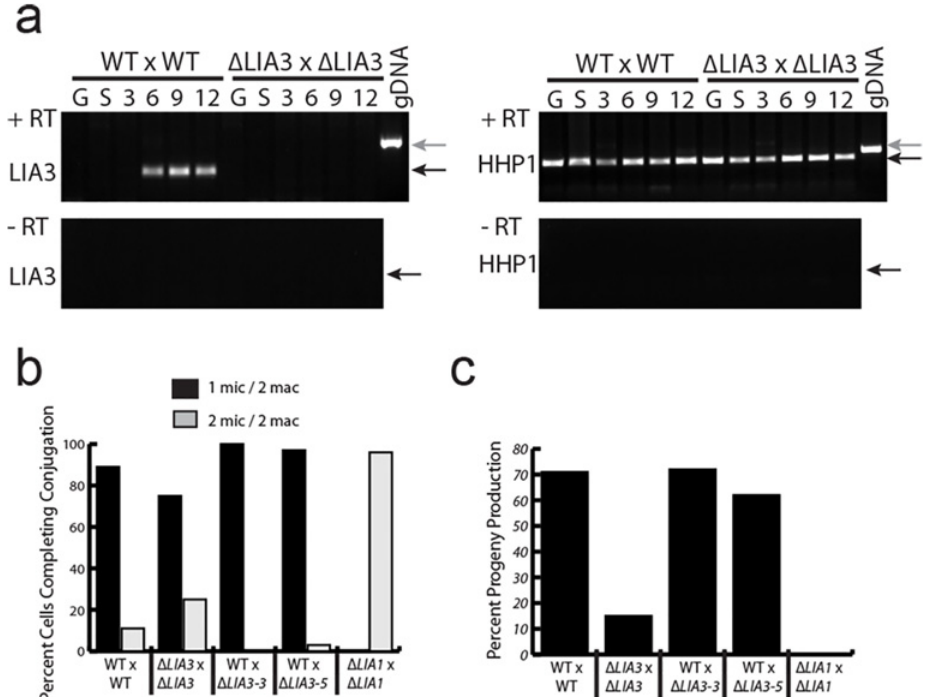
Fig 1. Δ LIA3 matings have reduced progeny production. (A) rt-pcr of vegetatively growing (G), starved (S), and conjugating cells (3, 6, 9, and 12 hrs postmixing). HhpI is used as a loading control. Black arrows point to cDNA band; grey arrows point to DNA band. Reverse transcriptase was omitted when synthesizing the cDNA for the bottom gels to confirm lack of gDNA contamination in RNA samples. (B) Percent of cells that either complete conjugation by resorbing one of their micronuclei or do not complete conjugation and maintain two micronuclei. (C) Percent of mated pairs that produce viable progeny for each mating. N > 200 for WT x WT and Δ LIA3 x Δ LIA3 . N > 45 for WT x Δ LIA3 matings. For b and c, Δ LIA1 mating data from